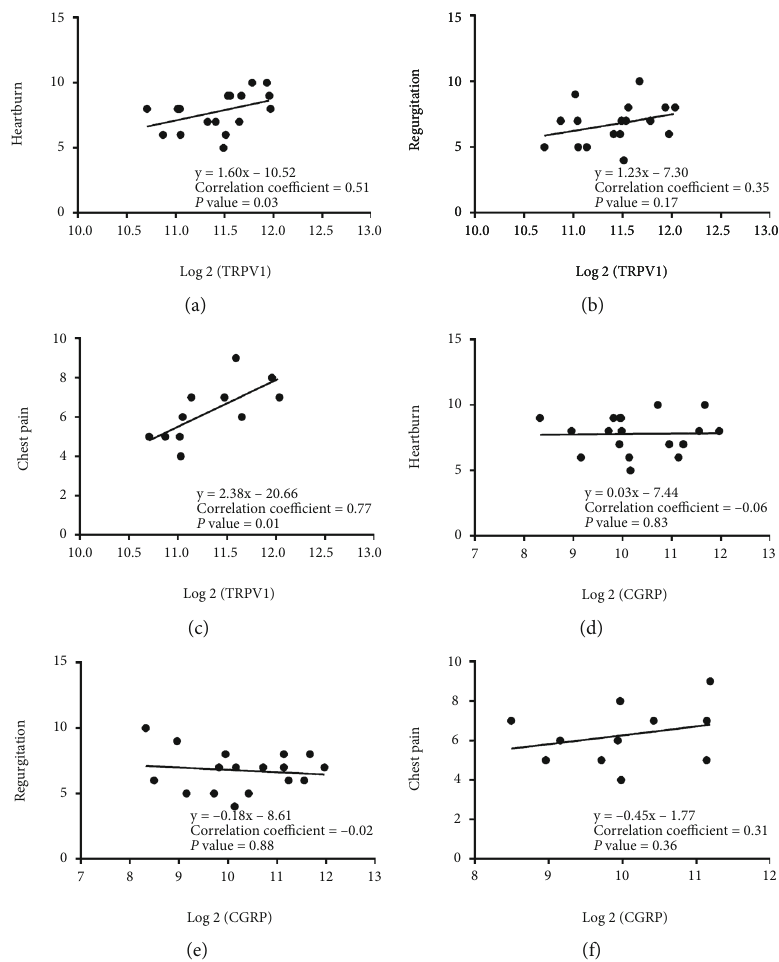
Figure 5: Correlations between symptoms and the positive cell density of TRPV1 and CGRP. TRPV1 was moderately and highly correlated with heartburn (a) and chest pain (c), but not regurgitation (b), respectively. However, CGRP was not signi fi cantly related to any symptoms (d –